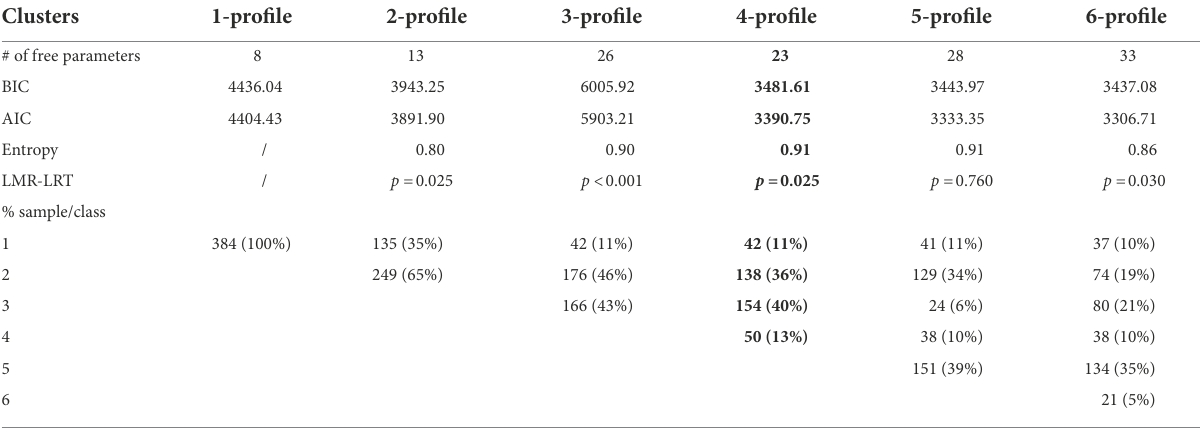
N = 384. Bold indicates the best